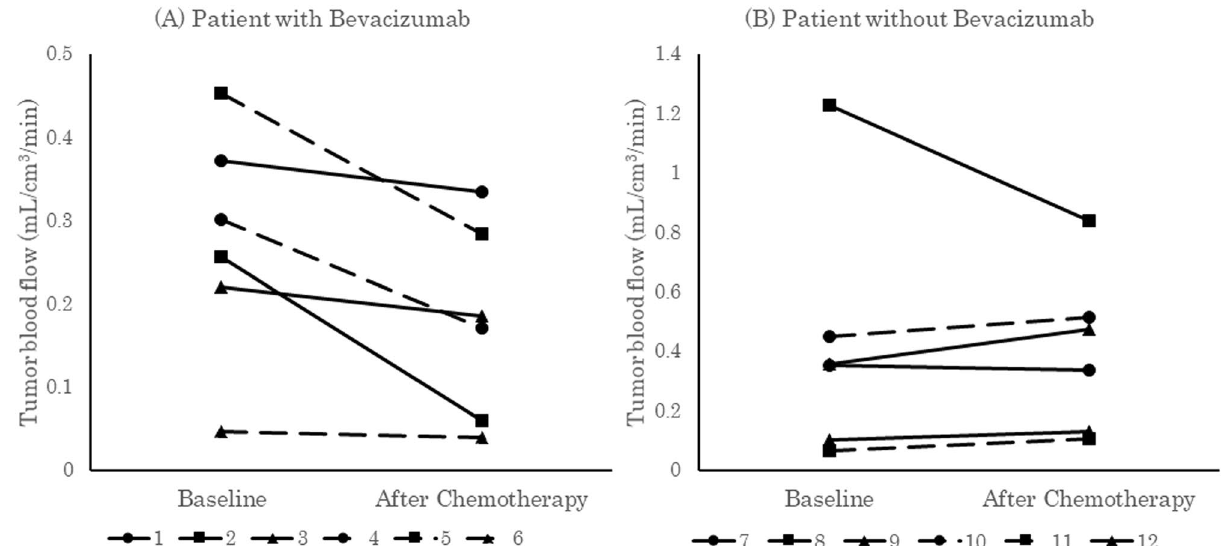
Figure 2. Tumor blood flow before and after chemotherapy in each patient. ( A ) Patients who underwent chemotherapy with bevacizumab. There was a statistically significant decrease in blood flow. ( B ) Patients who underwent chemotherapy without bevacizumab. There was no statistically significant change in blood